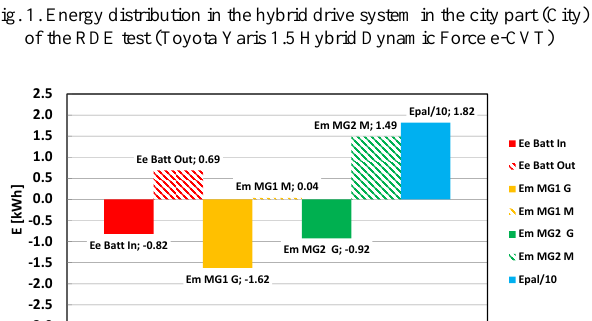
Fig. 2. Energy distribution in the hybrid drive system in the motorway part of the RDE test (Toyota Yaris 1.5 Hybrid Dynamic Force e-CVT)